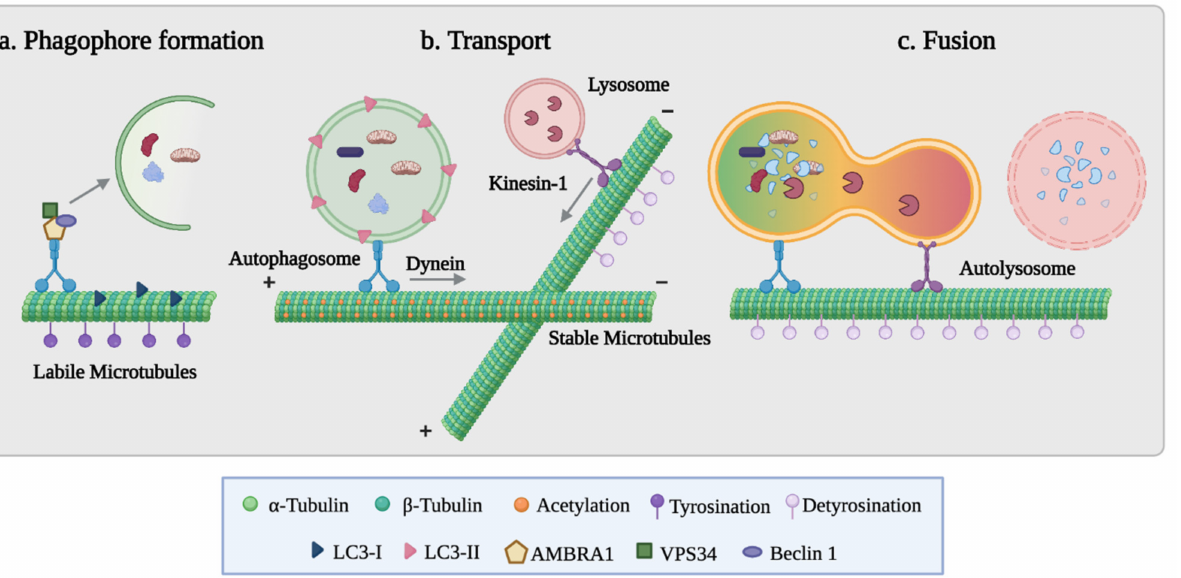
Figure 3. MTs harboring different tubulin post-translational modifications are involved in various stages of autophagy. ( a ) Phagophore formation occurs on labile, dynamic MTs that are characterized by tubulin tyrosination. Upon autophagy stimulation, ULK1-dependent phosphorylation of AM- BRA1, which is sequestered on labile MTs in growth conditions, initiates autophagosome formation. ( b ) Closed autophagosomes are transported along stable, acetylated MTs prevalently toward the MT minus end, while lysosomes are enriched on detyrosinated MTs through a kinesin 1-dependent mechanism. ( c ) Autophagosome–lysosome fusion intervenes on detyrosinated MTs. Image created with